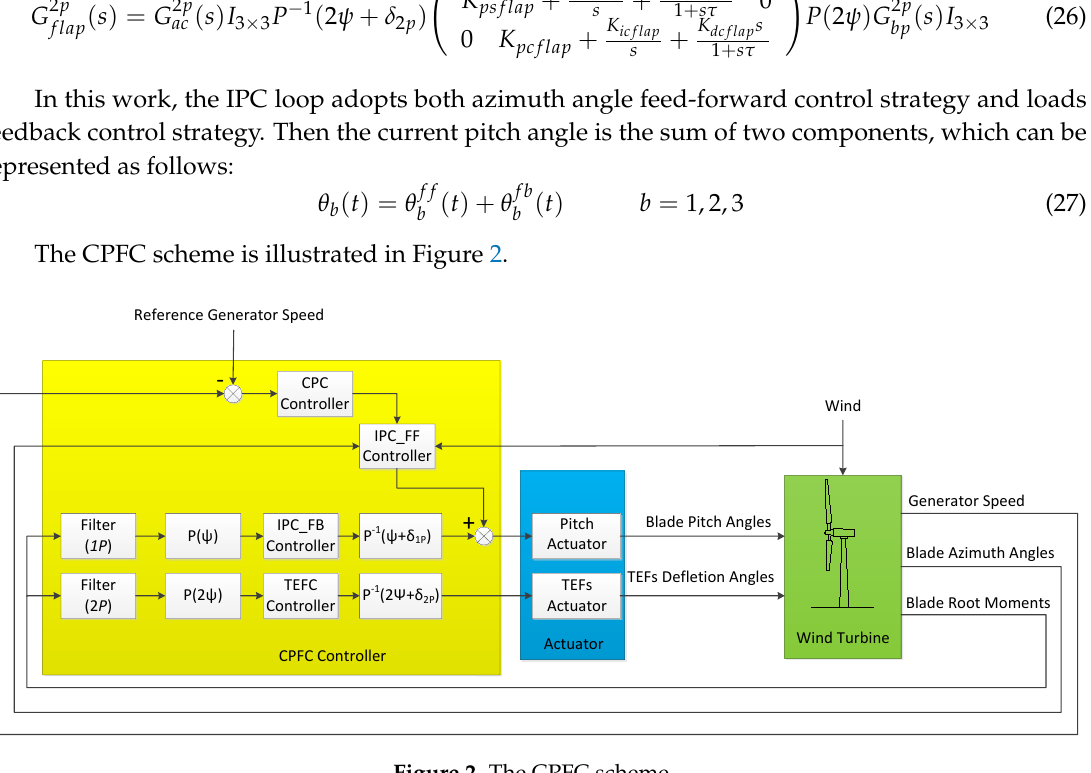
Figure 2. The CPFC scheme.